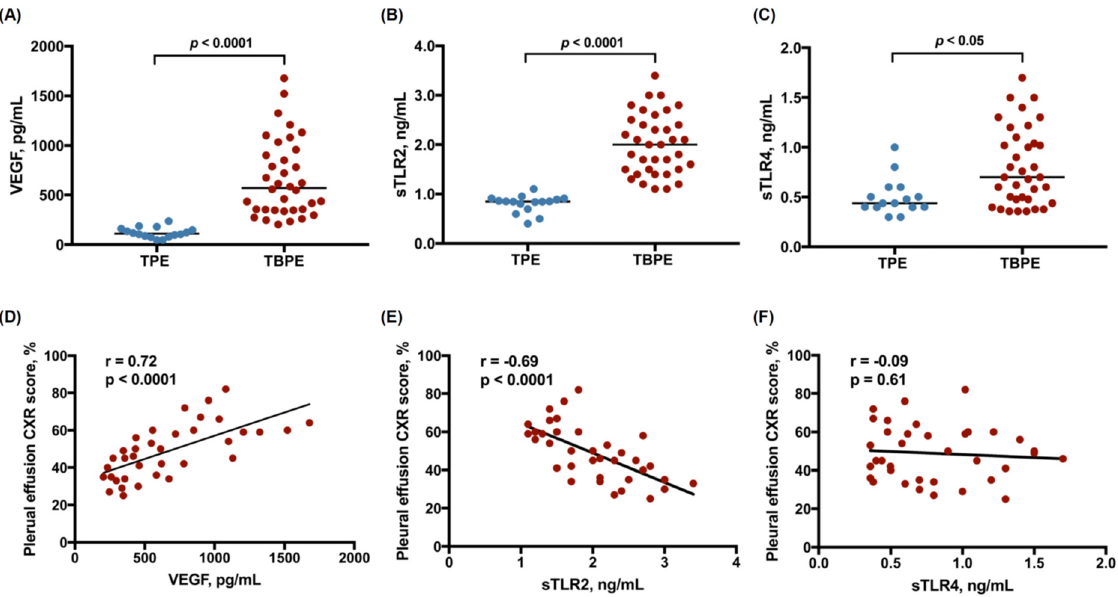
Figure 1. Levels of VEGF, sTLR2, and sTLR4 between TPE and TBPE ( A – C ) and their correlation with pleural effusion CXR score in TBPE patients ( D – F ). TPE, transudative pleural effusion (n = 16); TBPE, tuberculous pleural effusion (n = 36); VEGF, vascular endothelial growth factor; sTLR2, soluble Toll-like receptor 2; sTLR4, soluble Toll-like receptor 4.